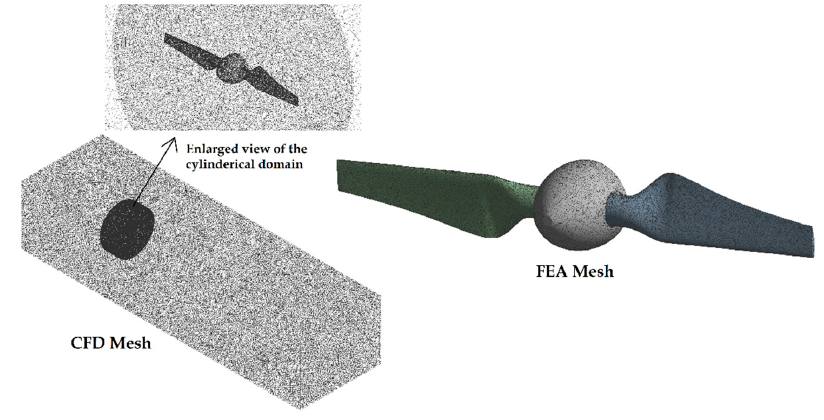
Figure 1. Domain and mesh used for the analysis.